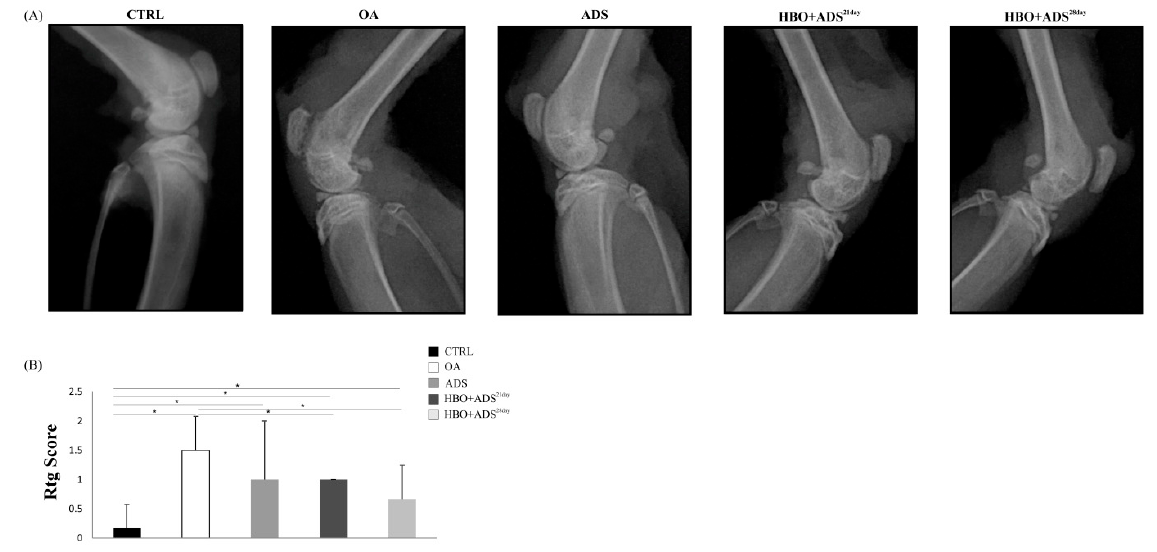
Figure 2. ( A ) Representative radiography images and ( B ) graphic analysis of knee joints in CTRL, OA, ADS, HBO+ADS 21day and HBO+ADS 28day groups. Values are presented as means ± mean stand- ard error (SE). * p < 0.05 indicates statistically significant differences between